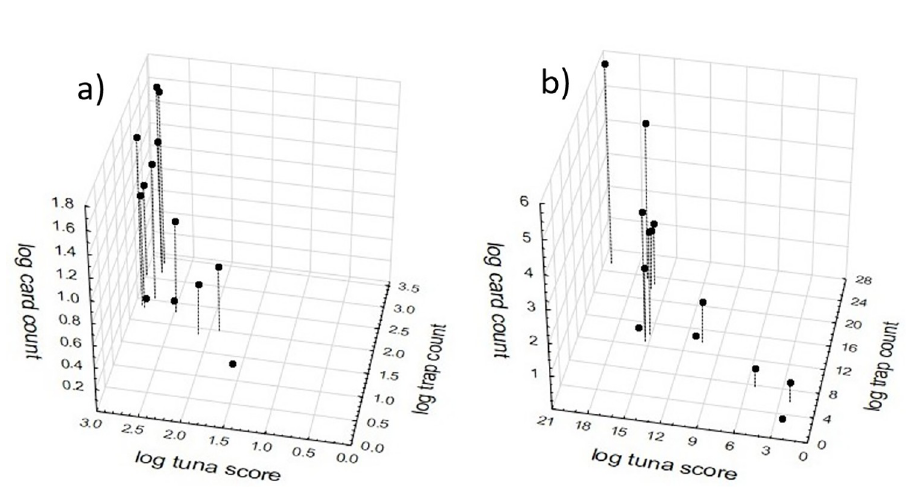
Fig 2. 3D scatterplots of the relationship between A . gracilipes abundance determined by the three sampling methods of card counts, pitfall trapping and tuna lures using transect-level data compiled from first pooling sample-level data then applying a log(x+1) transformation (a) and transect-level data compiled by pooling sample-level data that had first undergone a log(x+1) transformation (b).